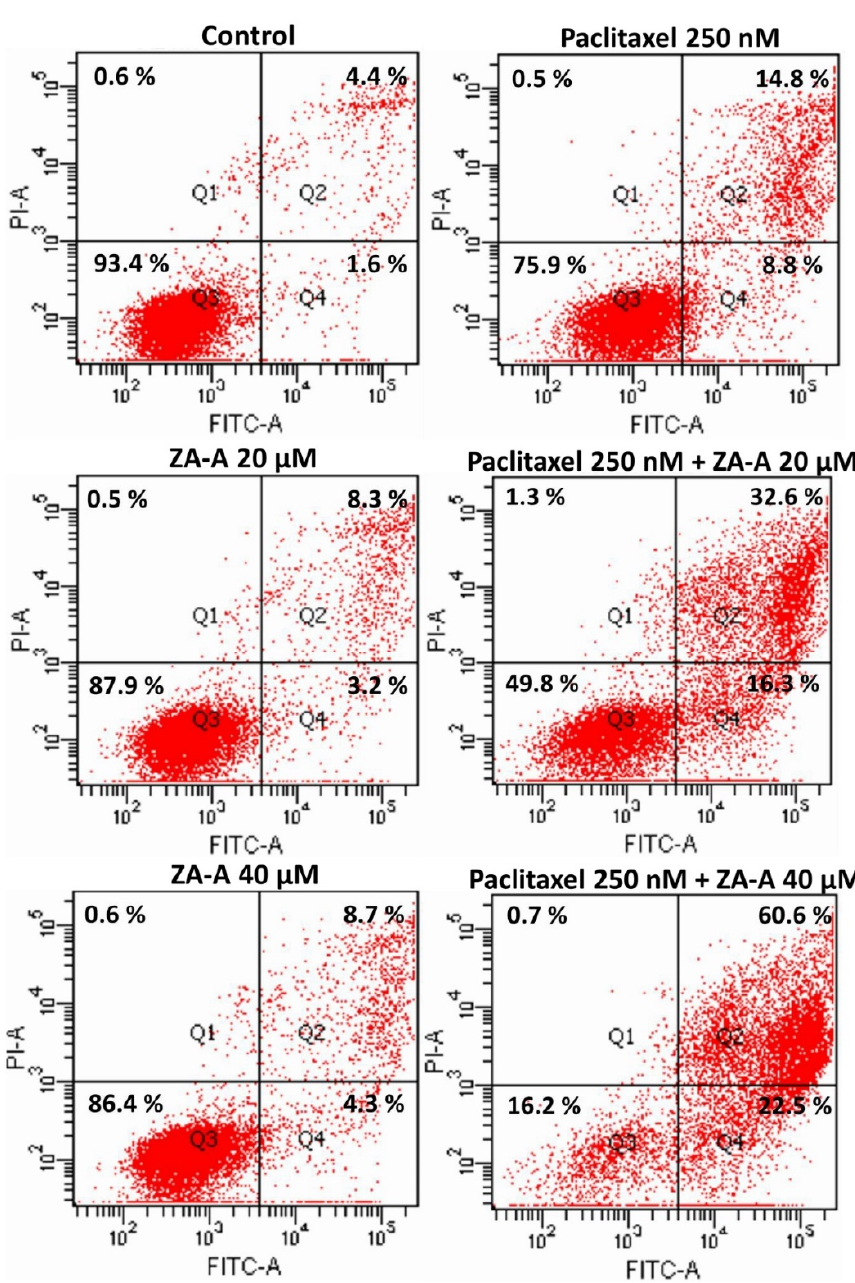
Figure 4. The cell cycle and apoptosis analyses of ZA-A and paclitaxel combinatorial treatment. ( a ), ( b ), ( c ) and ( d ) The cell cycle distribution of 72 h treatment in Flp-In TM -293, ABCB1 / Flp-In TM -293, HeLaS3 and KB / VIN, respectively. Data were presented as mean ± SE of at least three experiments, each in triplicate. ( e ) The apoptosis phenomenon of 72 h treatment in KB / VIN cell line. Apoptosis and necrosis status of each sample was determined by annexin V (X-axis FITC) and PI (Y-axis PI). Cells distributed in Q1, Q2, Q3 and Q4 represent necrosis, late-apoptosis and normal and early-apoptosis, respectively.